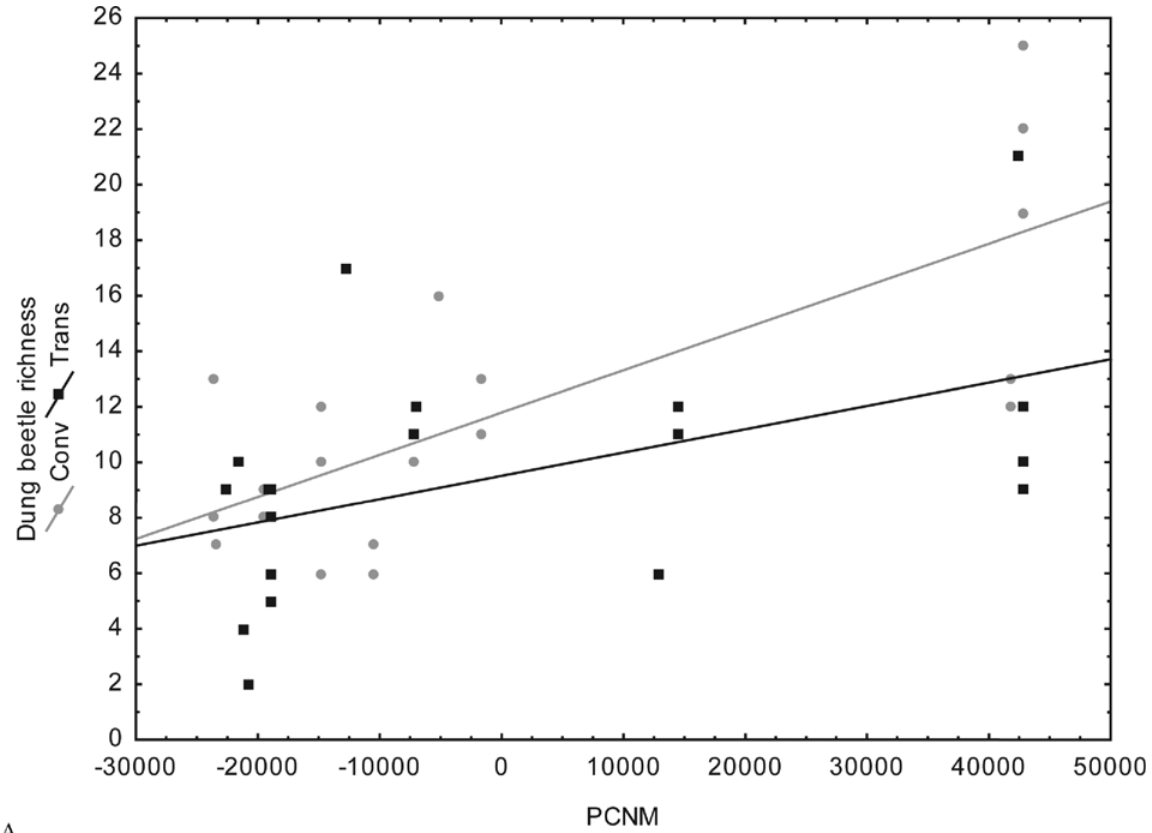
Fig 3. Distribution of dung beetle species richness in relation to spatial distance (PCNM) in 40 Atlantic Forest fragments adjacent to transgenic and conventional maize in Campos Novos, Southern